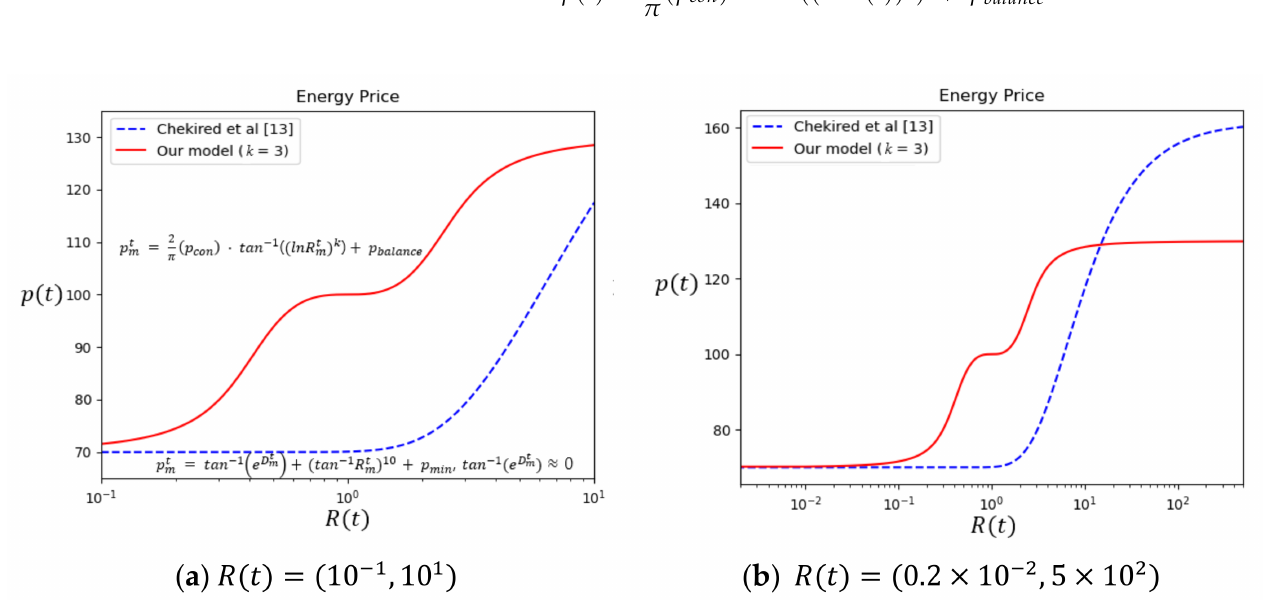
Figure 1. Comparison of our pricing model (solid red line) with ( k = 3) against Chekired et al. [13] (dotted blue line), with p balance = 100, p con = 30. ( a ) R ( t ) =